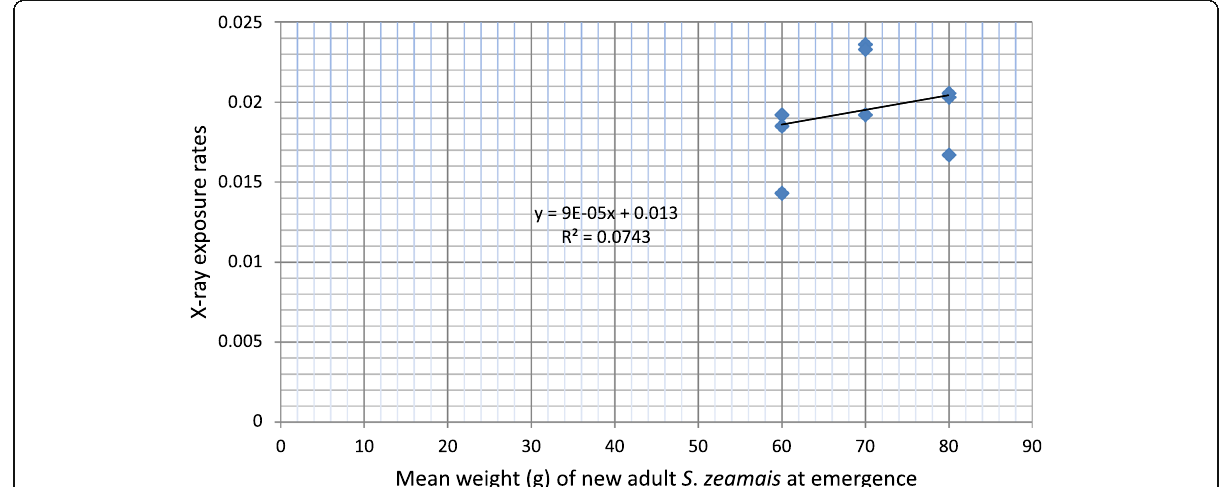
Fig. 5 Association between X-ray exposure dose and weight of Sitophilus zeamais adults at emergence from maize